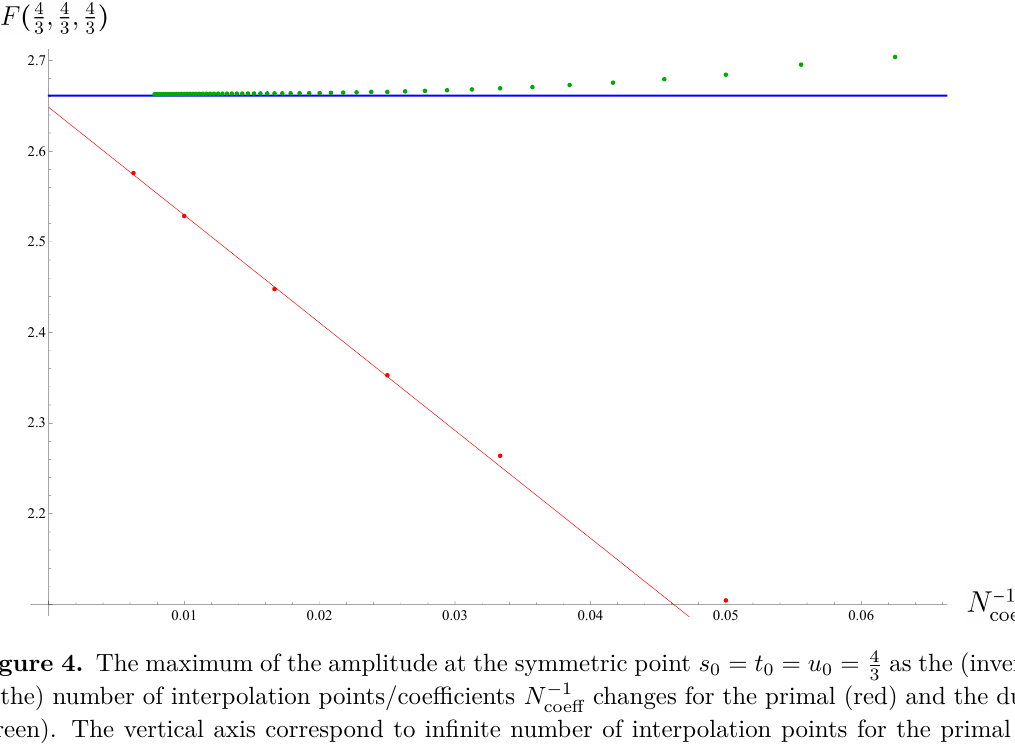
as the (inverse 3 changes for the primal (red) and the dual coeff